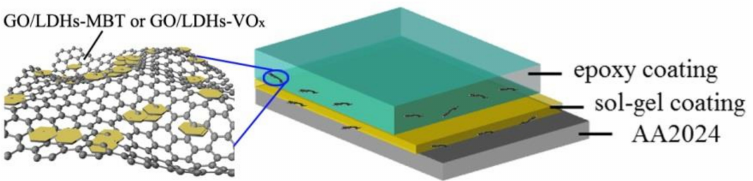
Figure 1. Schematic diagram of coating system added with different combinations of the